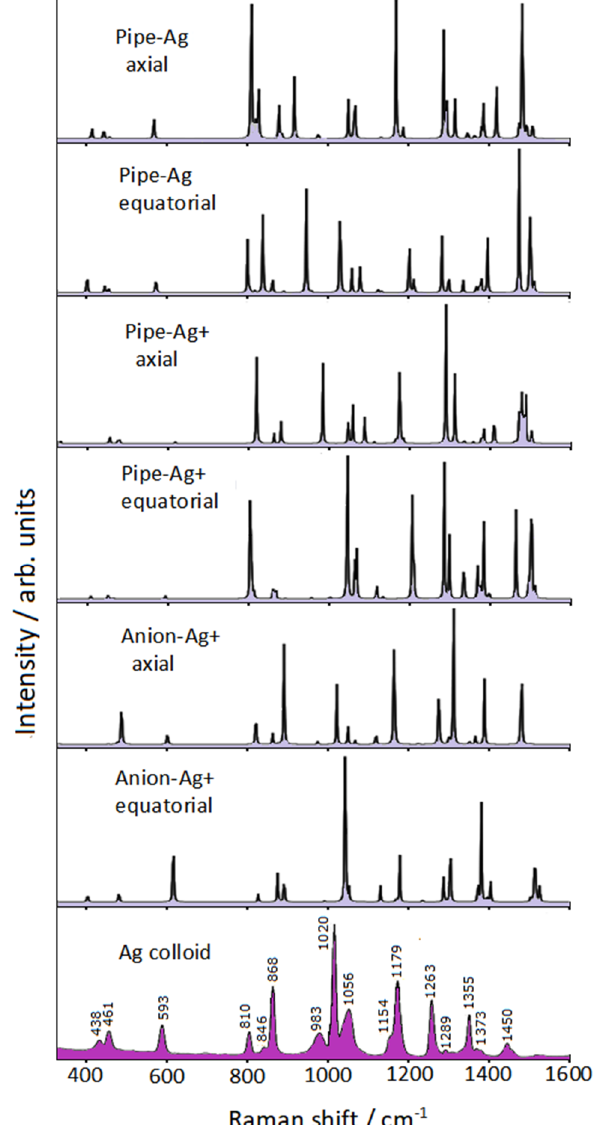
Figure 4. Raman spectra of silver/piperidine complexes compared with the SERS spectrum of piperidine in Ag colloid.